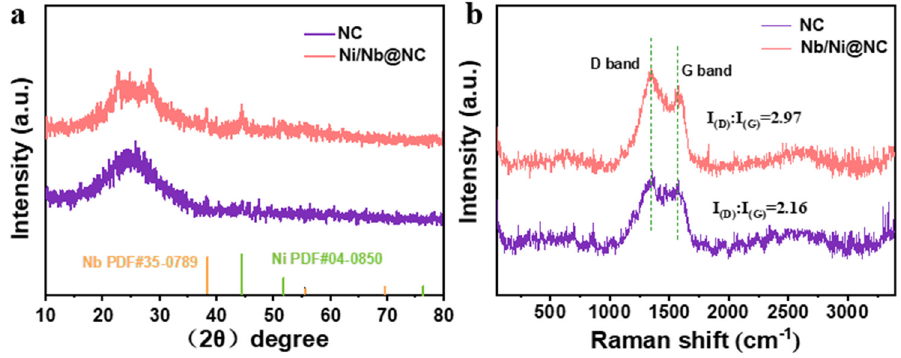
Figure 2. ( a ) XRD pattern of Nb/Ni@NC and NC nanofibers; ( b ) Raman spectra of Nb/Ni@NC and NC nanofibers. NC